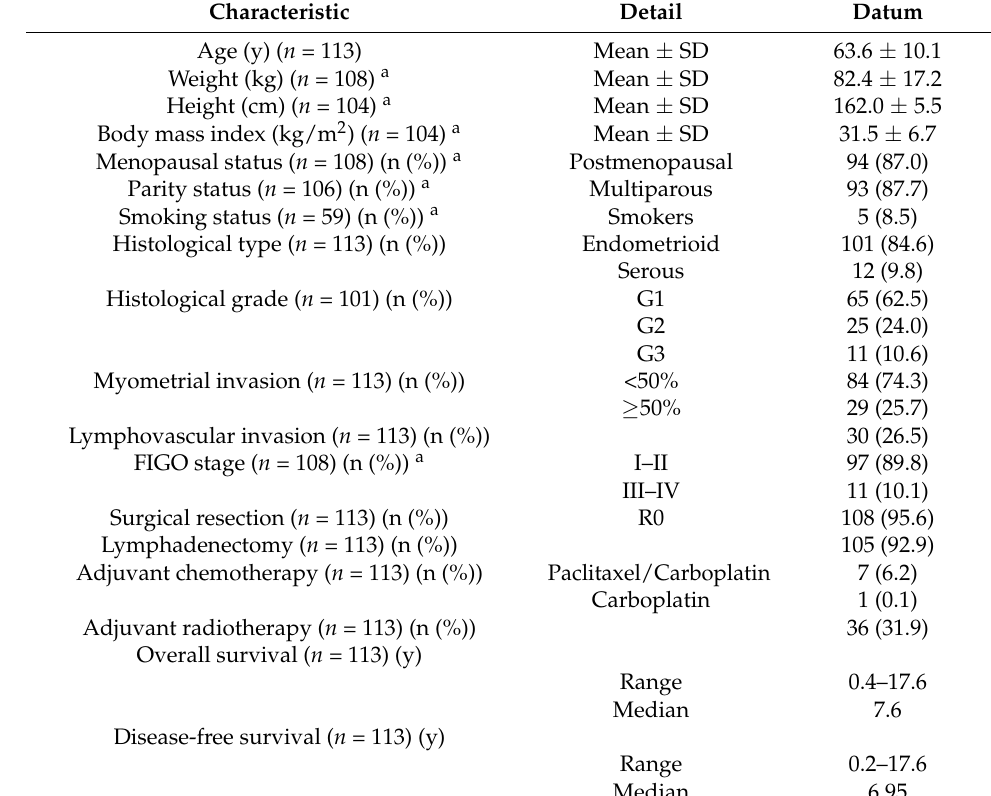
Table 1. Clinical and histopathological data of the patients with